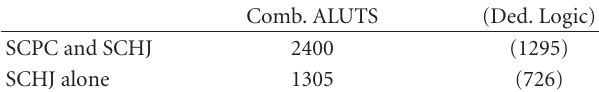
Table 2: Implementation